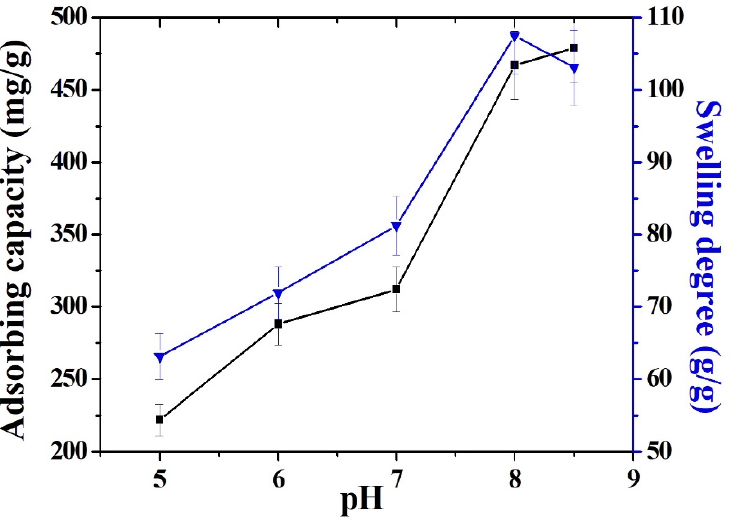
Figure 7. Effects of pH value on the swelling degree and the amount of lysozyme adsorbed on the composite aerogel. composite